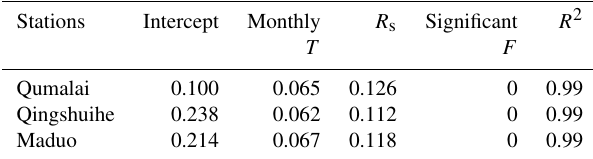
Table 4. Regression Model for potential evaporation